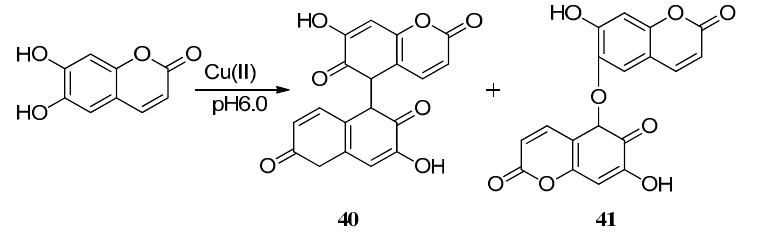
Scheme 13. The method of forming dimers.